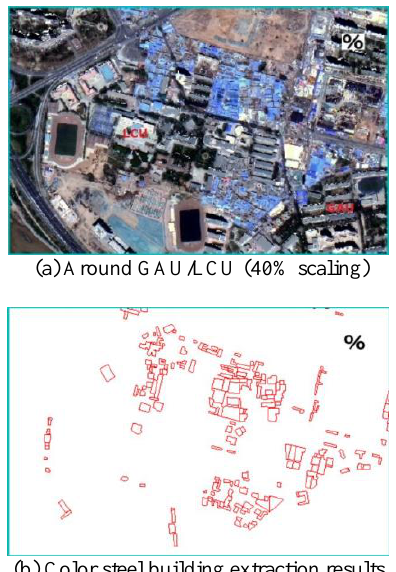
Figure.1 The small color steel buildings extraction based on the GF-2 images